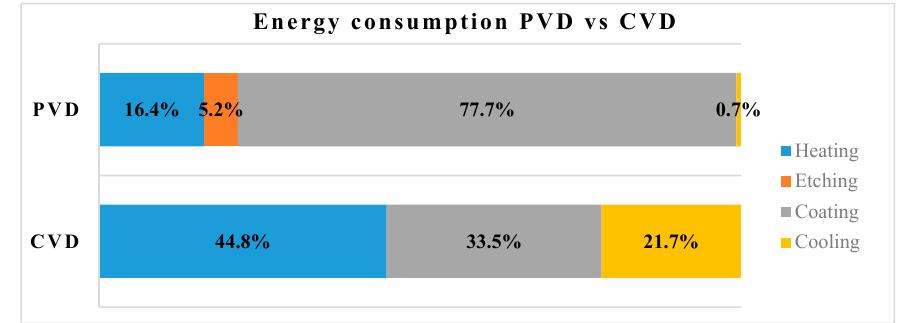
Figure 4. Energy consumption in the different steps of the PVD process: Heating, Etching, Coating, and Cooling. Energy consumption in the steps of the CVD process: Heating, Coating, and Cooling.